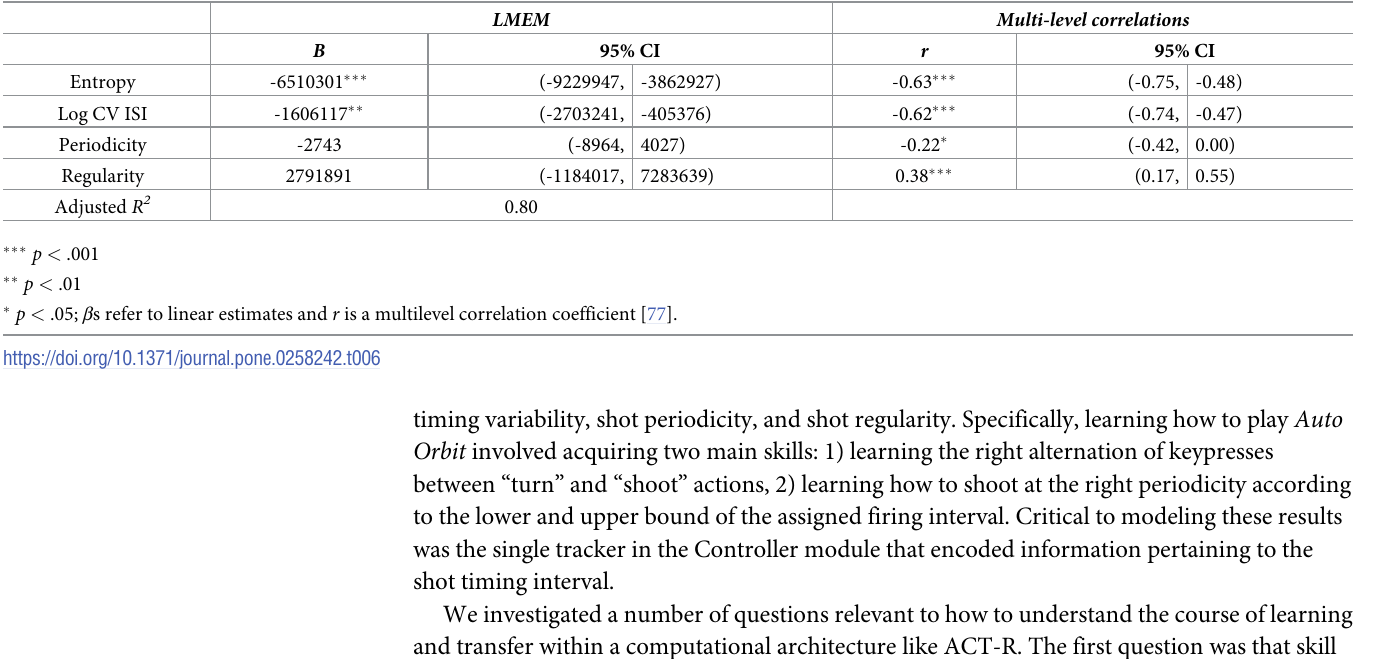
Table 6. Linear mixed-effects model and multilevel correlations of inter-individual differences in skill.